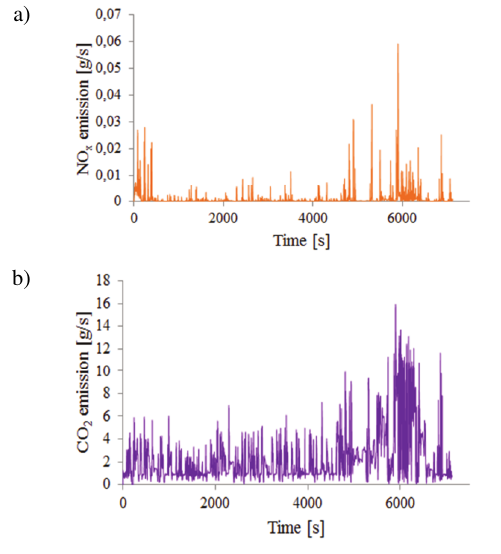
Fig. 11. Measured compounds emission per second: a) NO x , b) CO